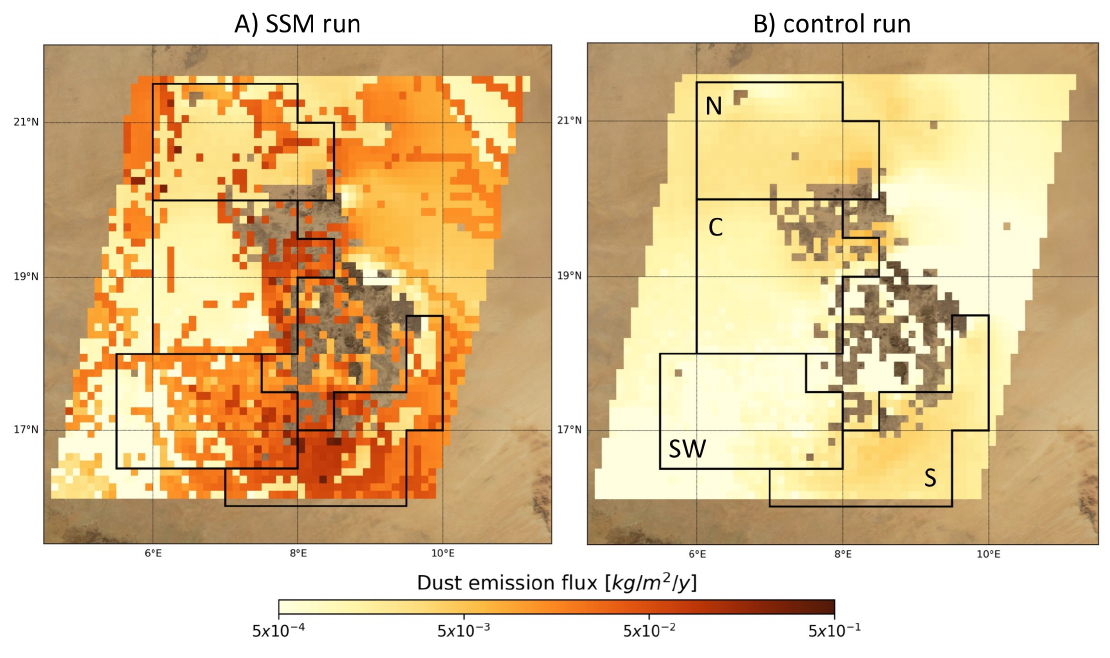
Figure 8. Modeled dust source activation frequency for the study area including the four hot spot zones determined in the satellite-based DSAF-analysis (Figure 5) for the original model run including the SSM run ( A ) and for the control run ( B ) with constant size distribution of available